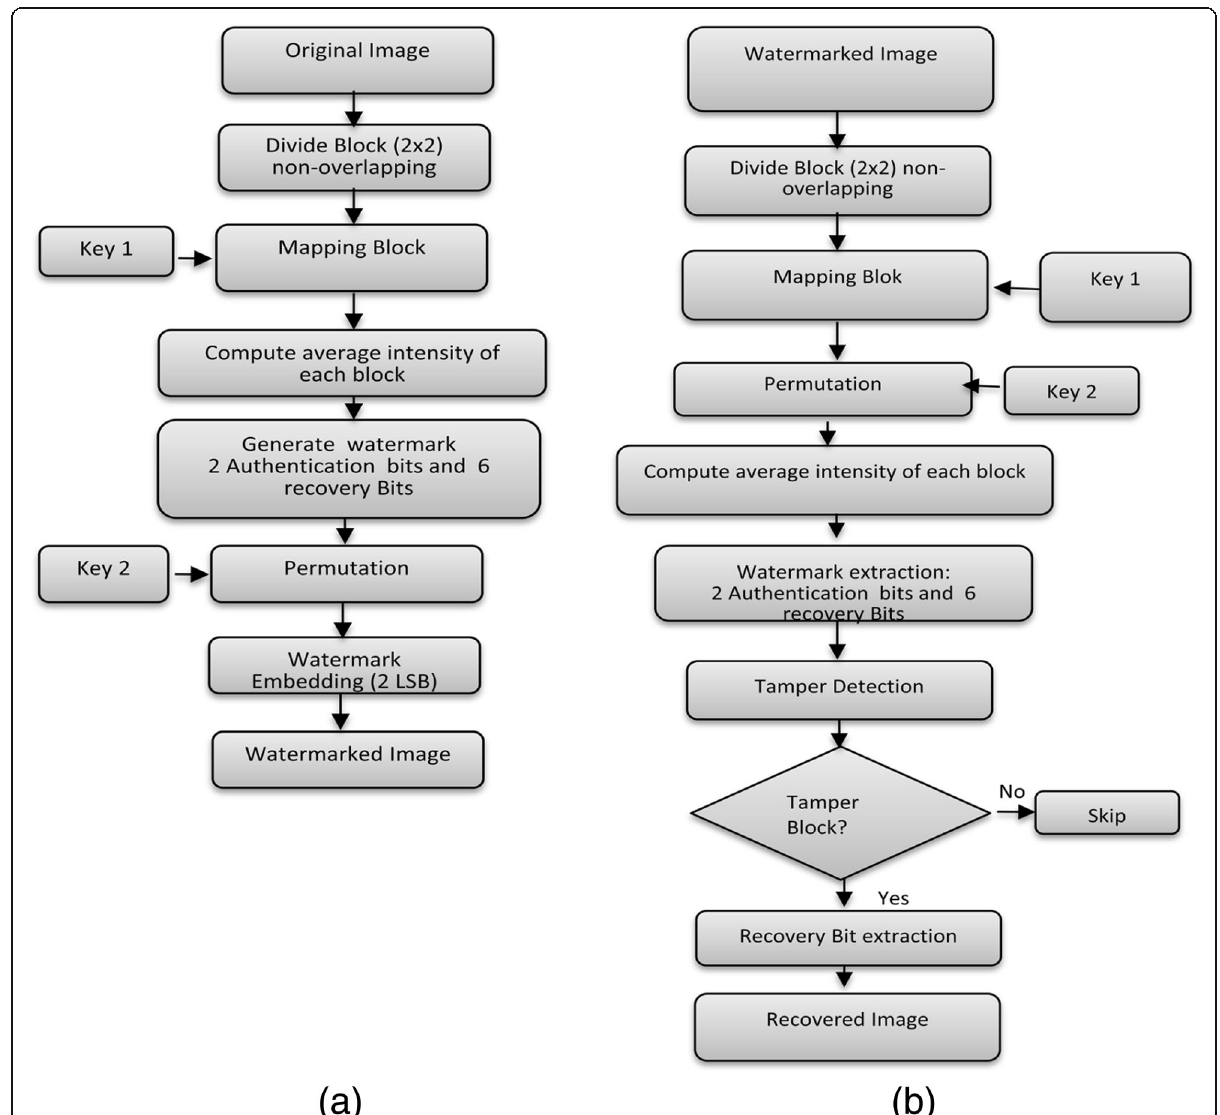
Fig. 14 Block diagram of ( a ) watermark embedding and ( b ) extraction process for Cao et al. ’ s method